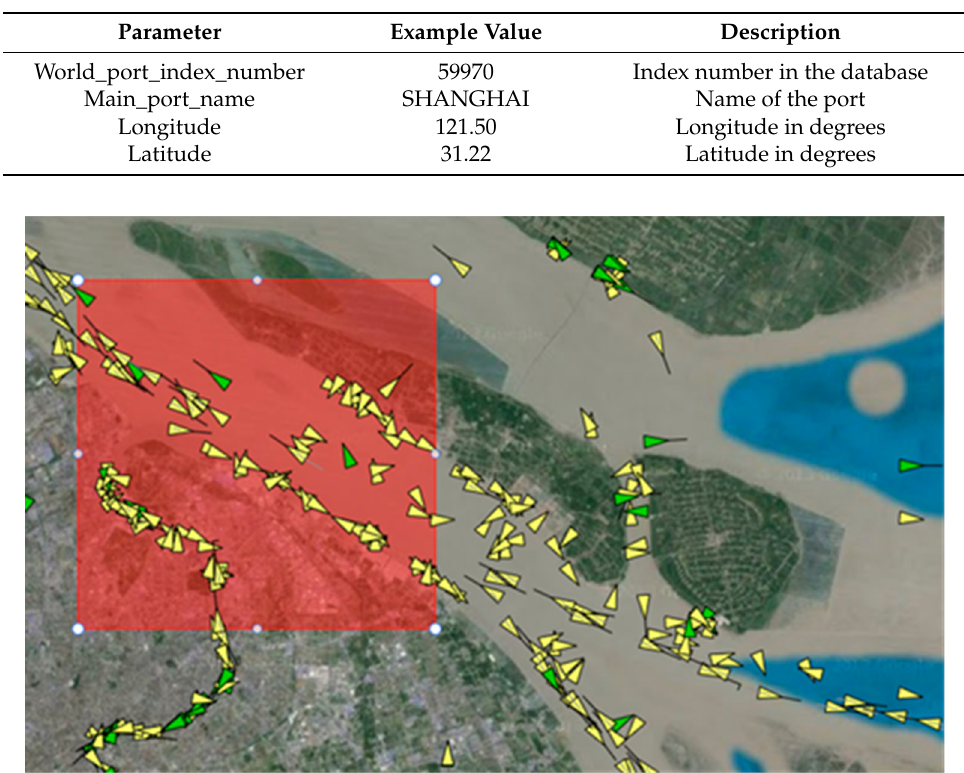
Figure 1. Screenshot of the “ships in port” service provided by Elane Inc. The boundary of port Shanghai is represented as the red rectangle, and a ship is regarded as in this port if, and only if, it is inside this rectangle.